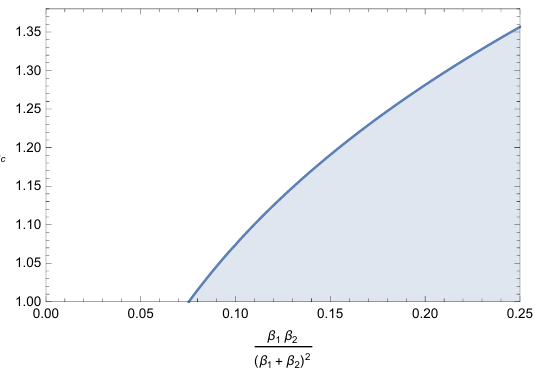
Figure 3 . The critical value of b as a function of β 1 β 2 with b < b c , which are stable against the nucleation of 3-brane